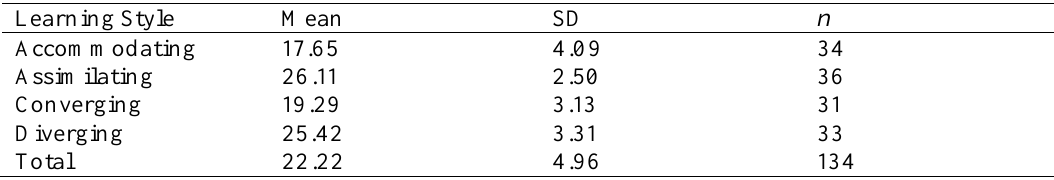
Observational Modelling through Mobile